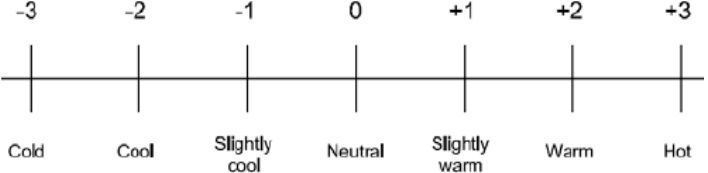
Figure 1. American Society of Heating, Refrigeration and Air Conditioning Engineers (ASHRAE): s 7-point scale for thermal comfort [65].